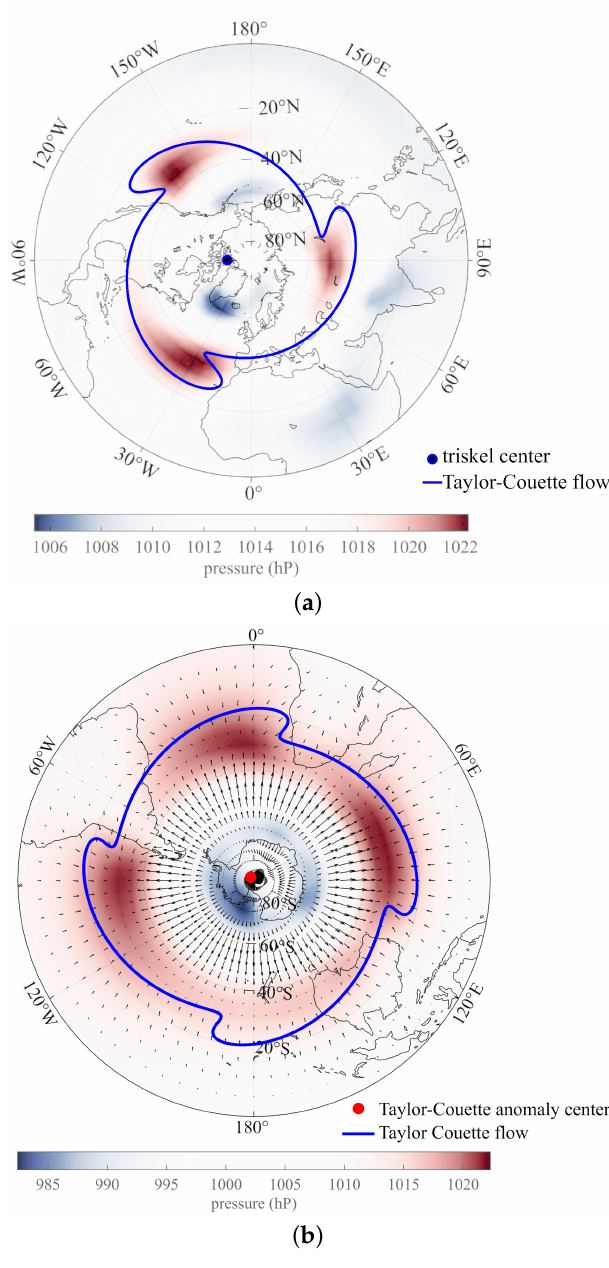
Figure 6. Superimposition of the Taylor–Couette patterns for both North and South Hemispheres. ( a ) Superimposition of the triskeles’ Taylor–Couette pattern of flow for mode q = 3 and observed mean pattern of sea-level pressure in the North Hemisphere from 1850 to 2020. ( b ) Superimposition of the Taylor–Couette pattern of flow for mode q = 4 and observed mean pattern of sea-level pressure in the South Hemisphere from 1850 to